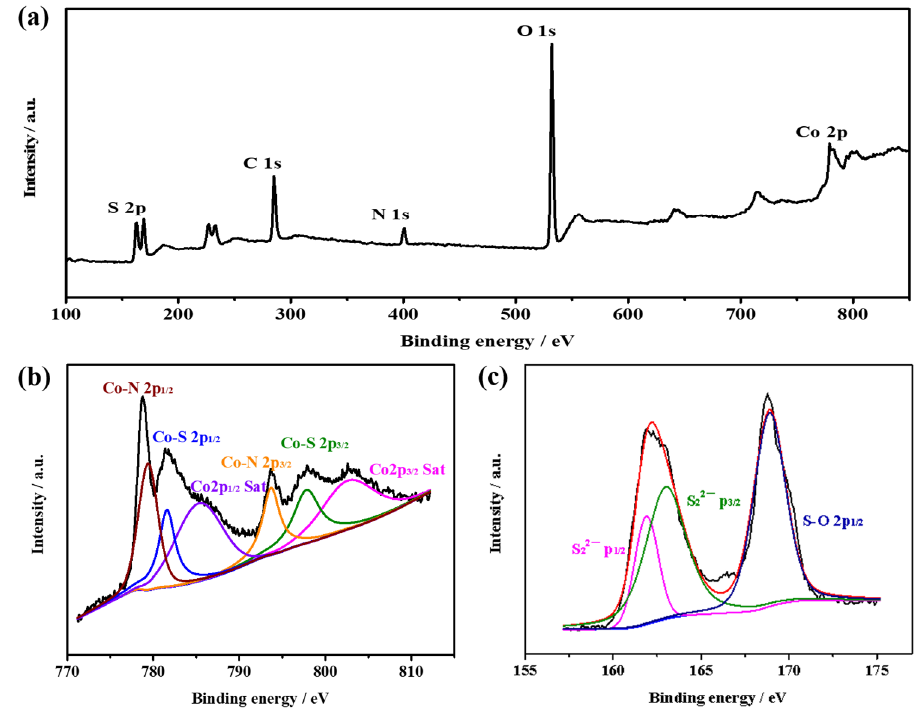
Figure 3. The wide scan XPS spectra of CoS 2 hollow nanoboxes ( a ) and the high-resolution Co 2p ( b ) and S 2p ( c ) spectrum.